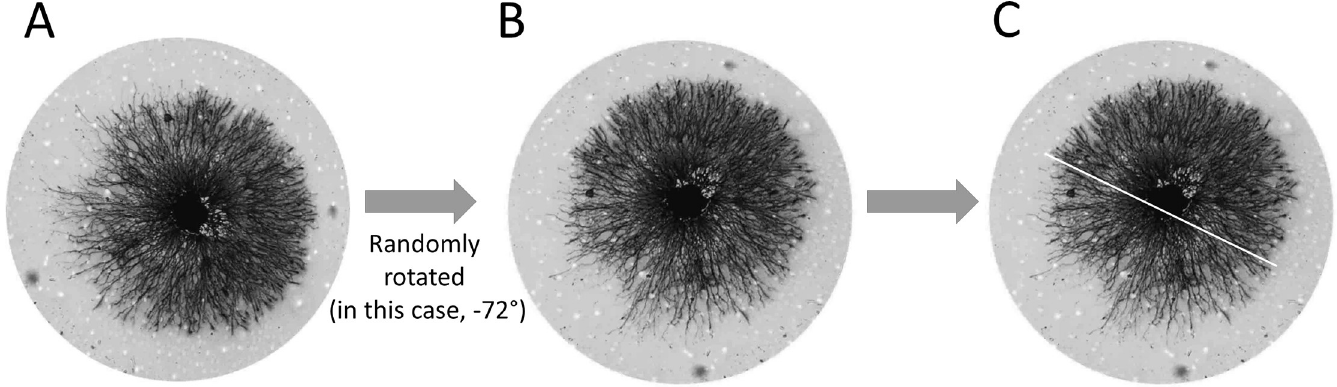
Fig 7. Method for quantifying the direction of morphological asymmetry. Each explant in a group was cropped using a circular field [A]. The image of each explant was rotated randomly. A different random rotation factor was used for each explant. In this example, the explant was rotated counterclockwise by 72 degrees [B]. An observer blinded to the original orientation was asked to assess the orientation of the rotated halo based on growth cone morphology [C]. The observer was asked to draw a line that best demarcates morphological differences on opposite sides of the halo.